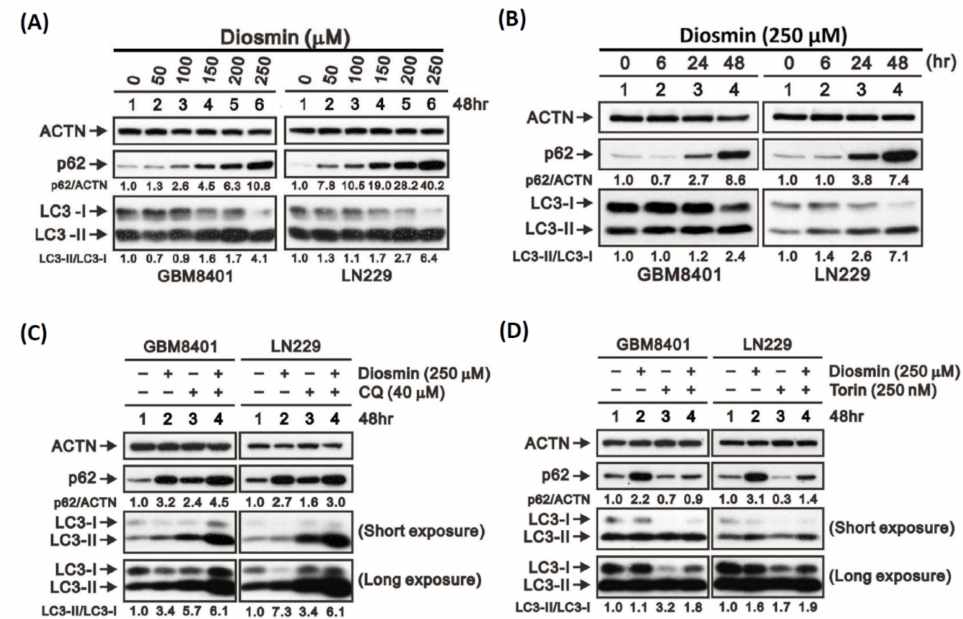
Figure 8. Diosmin is an autophagy inhibitor in GBM cells. ( A ) Western blotting of p62, LC3-I, and LC3-II in lysates from GBM8401 and LN229 cells incubated for 48 h with the indicated concentrations of diosmin. ( B ) Western blotting of p62, LC3-I, and LC3-II in lysates from GBM8401 and LN229 cells indicated with 250 µ M of diosmin for the indicated times. ( C , D ) Western blotting of p62, LC3-I, LC3- II, and β -actin in lysates from GBM8401 and LN229 cells incubated for 48 h with 10 µ M chloroquine (CQ) and/or 250 µ M diosmin ( C ) or 100 µ M torin and/or 250 µ M diosmin ( D